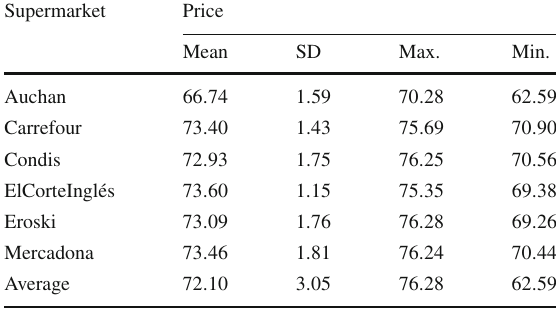
Table 6 Price of the occasional basket: alcoholic